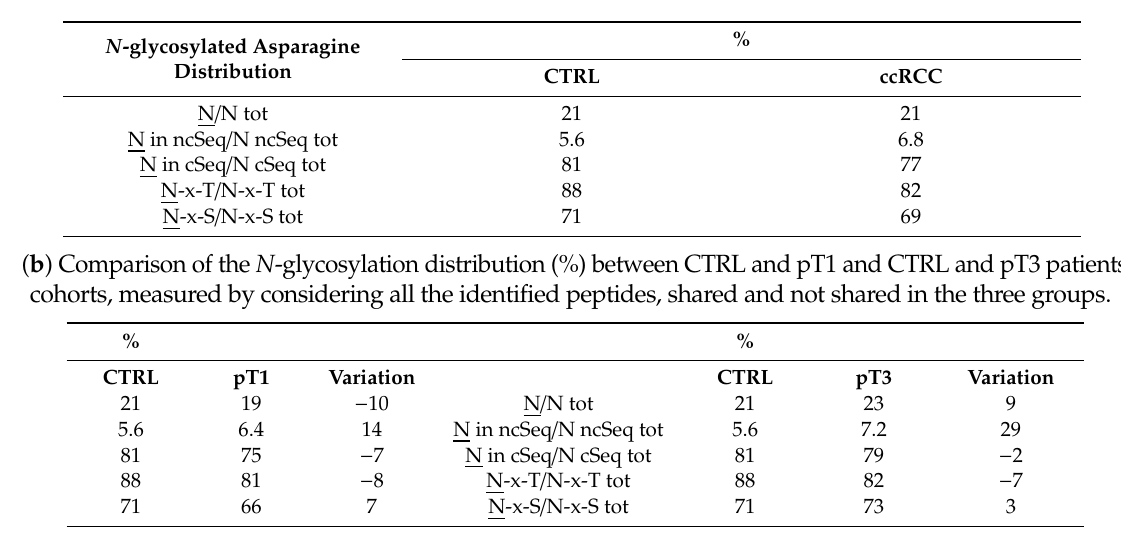
Table 2. The N -glycomapping of the urinary peptidome of CTRL and clear cell renal cell carcinoma (ccRCC)